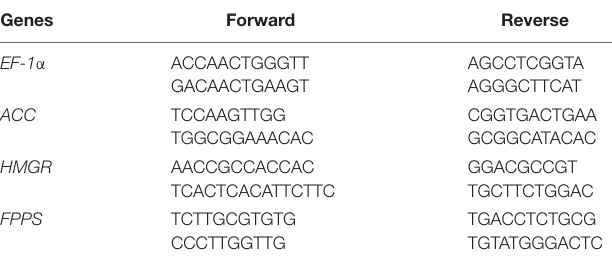
TABLE 2 | The list of forward and reverse primers used in the gene expression study.